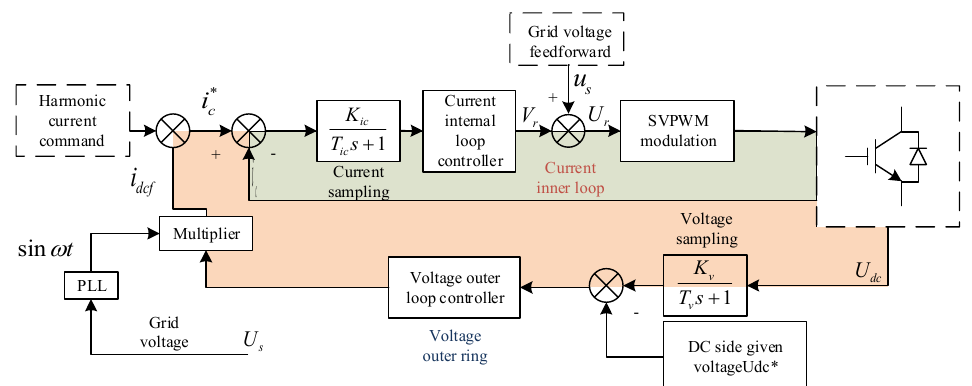
Figure 3. Single-phase PAPF overall composite control block diagram.